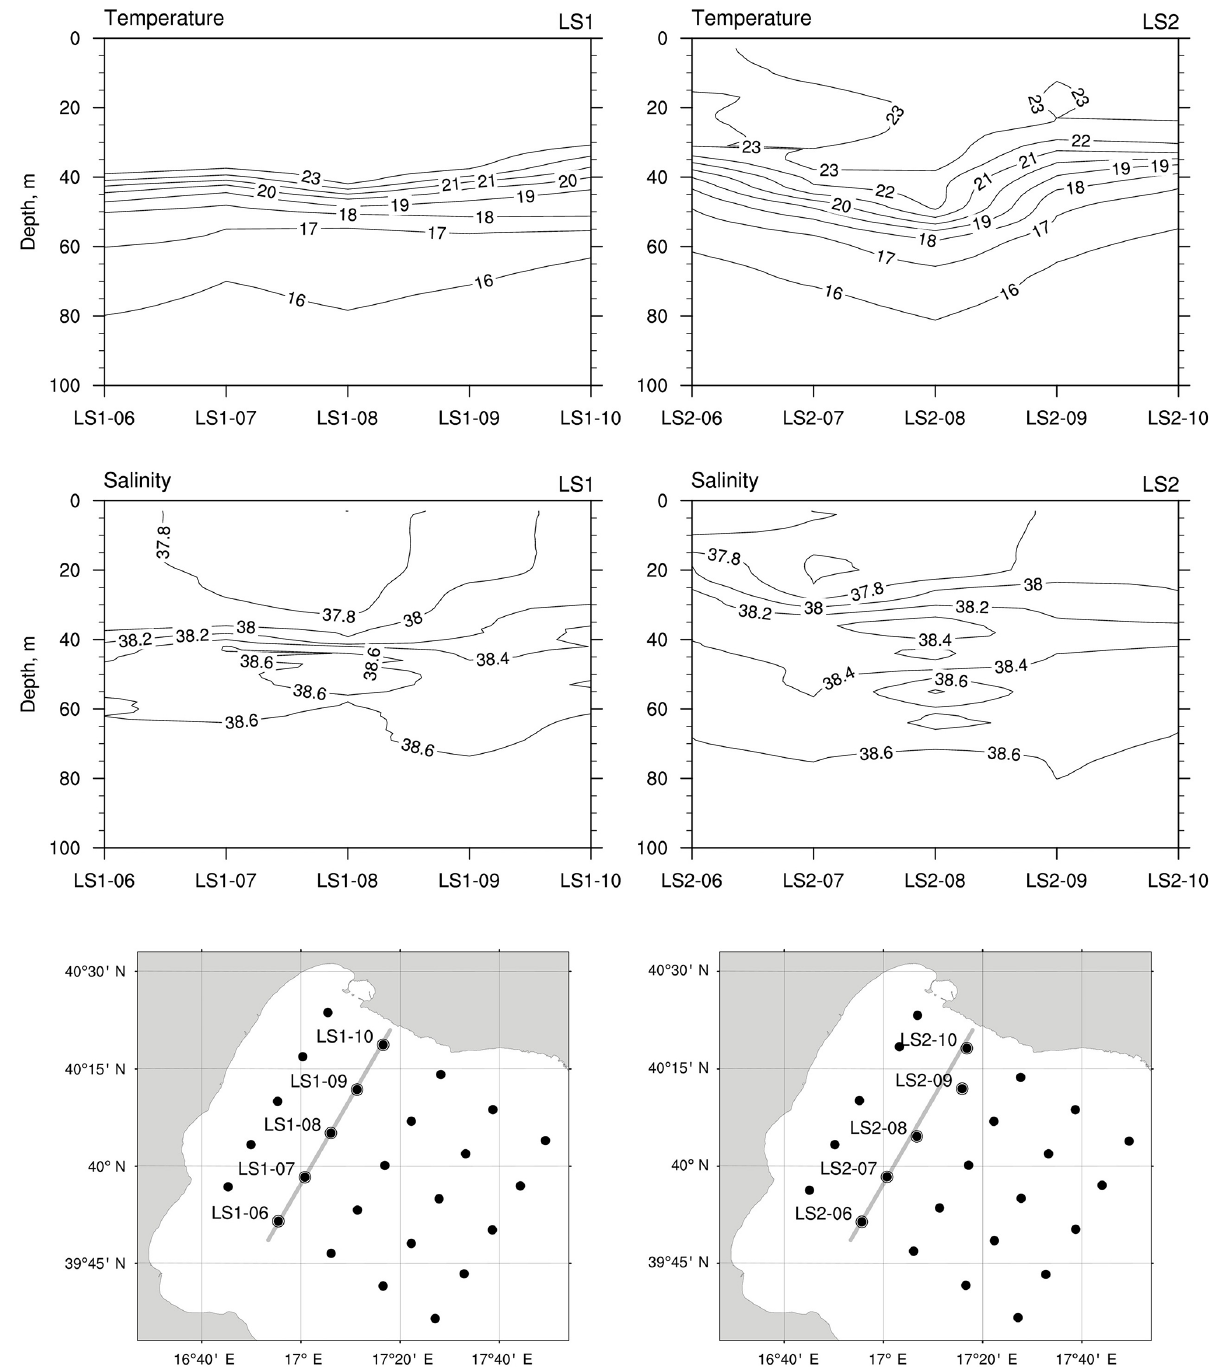
Figure 12. Temperature (top) and salinity (intermediate) transects for LS1 (left) and LS2 (right). The LS1 and LS2 transect stations are illustrated in the two bottom